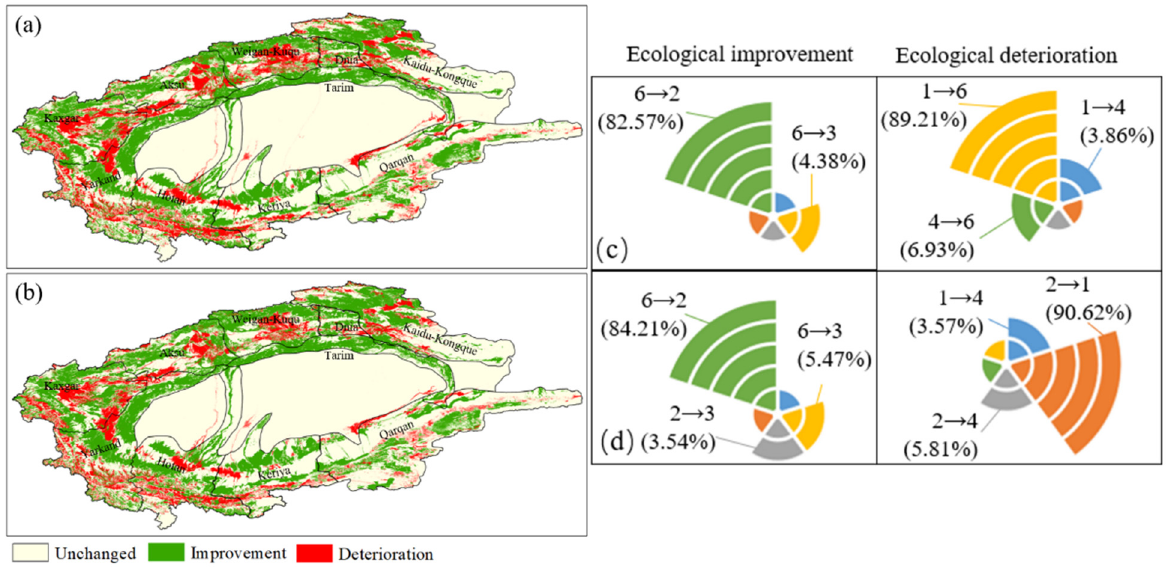
Figure 9. Future ecological changes in the Tarim River Basin: ( a ) 2019–2030; ( b ) 1990–2030; ( c , d ) future ecological contribution of the Tarim River Basin (1. cropland; 2. grassland; 3. woodland; 4. built-up land; 5. water bodies; and 6. barren land).